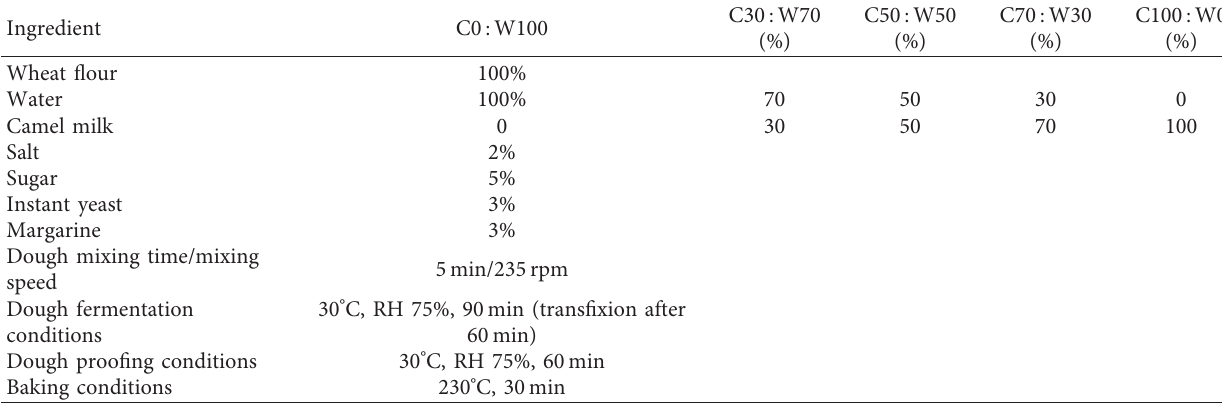
Table 1: Bread making